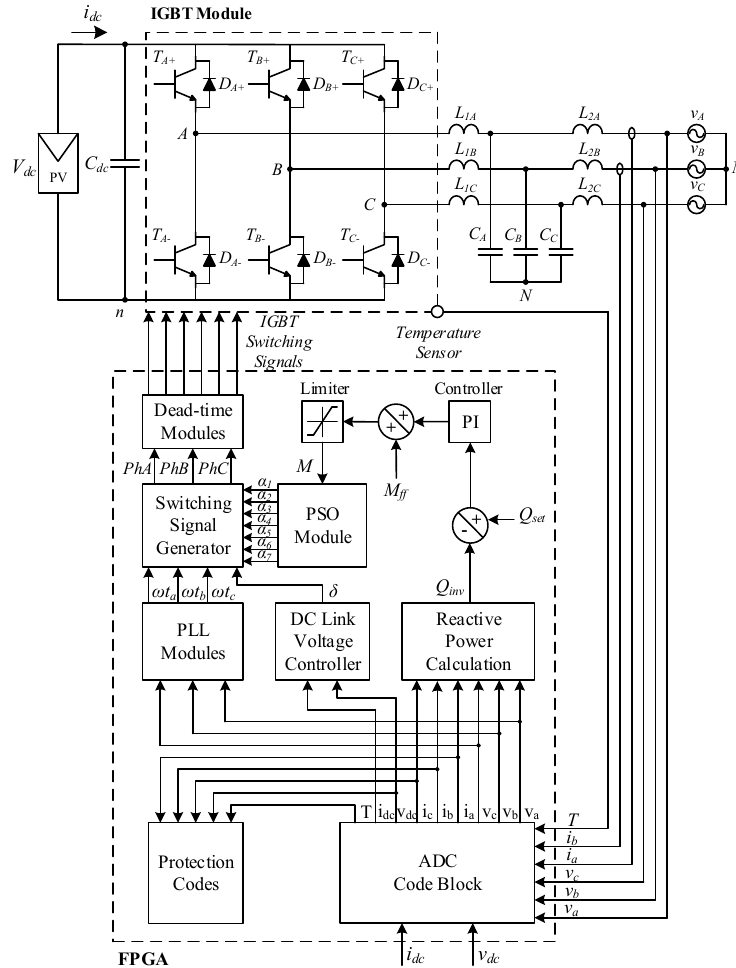
Figure 7. Three ‐ phase two ‐ level grid ‐ connected inverter controlled by a field ‐ programmable gate Figure 7. Three-phase two-level grid-connected inverter controlled by a field-programmable gate array array (FPGA). ADC, analog ‐ to ‐ digital converter. (FPGA). ADC, analog-to-digital